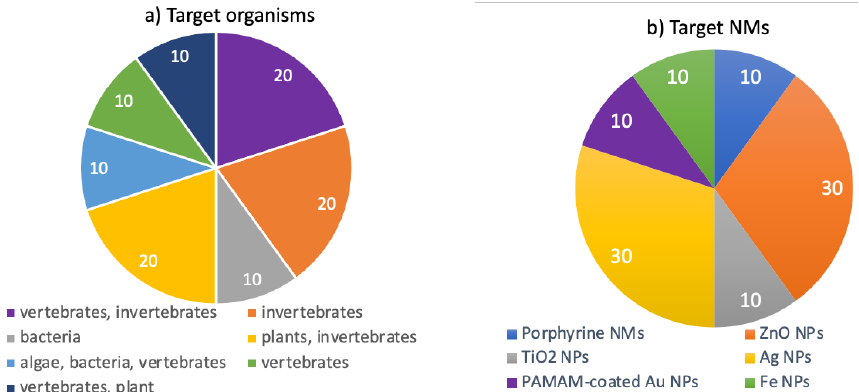
Figure 6. Overview of the selected papers targeting the ecotoxicity of nanomaterials in both aquatic and terrestrial environments, classified according to ( a ) the main target organisms and ( b ) nano-